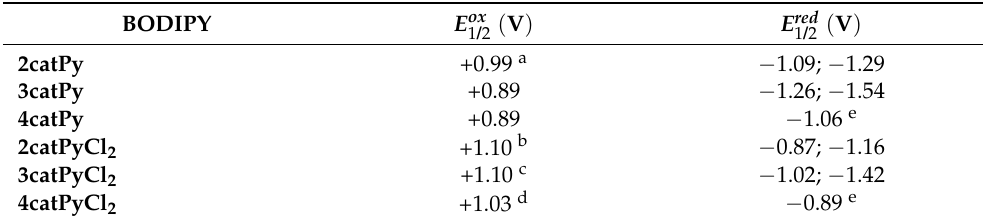
Table 3. Oxidation and reduction potentials for BODIPYs determined by cyclic voltammetry (in V vs. Fc + /Fc) at 100 mV/s in degassed and anhydrous acetonitrile with 0.25 M NBu 4 PF 6 at analyte concentrations of 0.001 M.